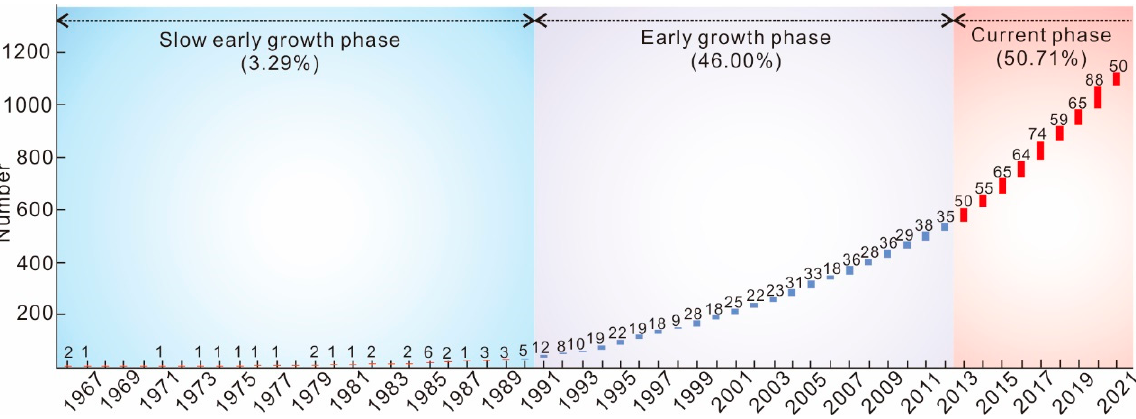
Figure 1. Annual number of articles on chromitite, based on data extracted from the WoSCC.